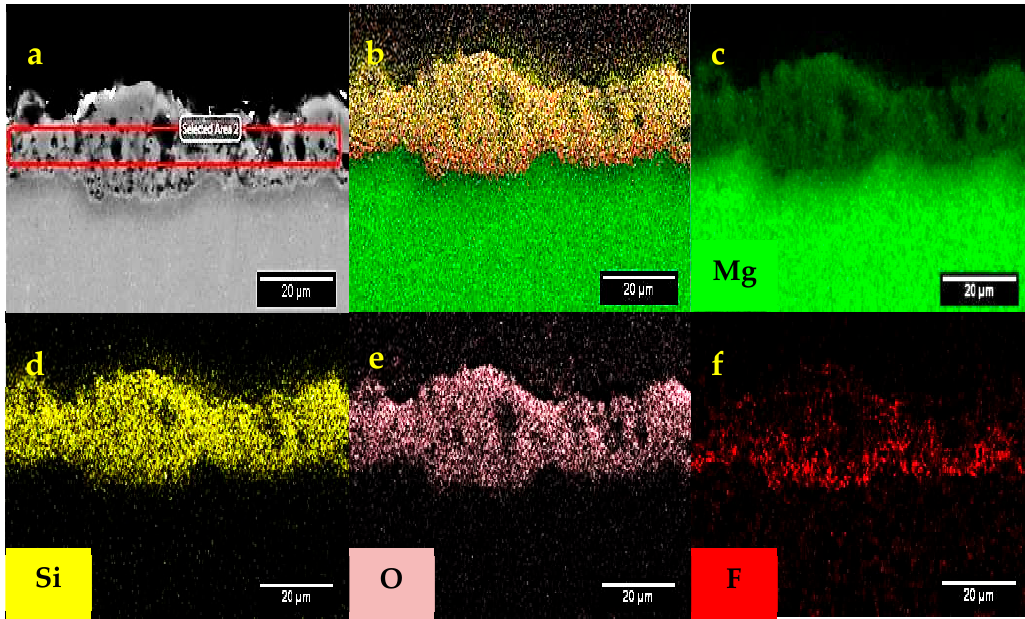
Figure 7. ( a ) Cross-section and elemental maps of B1 produced coating; ( b ) overall colors map, ( c ) map of magnesium, ( d ) map of silicon, ( e ) map of oxygen and ( f ) map of fluoride. Coatings 2019 , 9 , x FOR PEER REVIEW